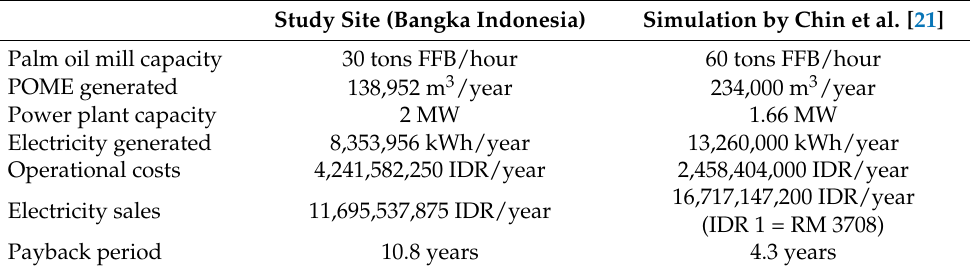
Table 7. Comparison of two electricity generations.